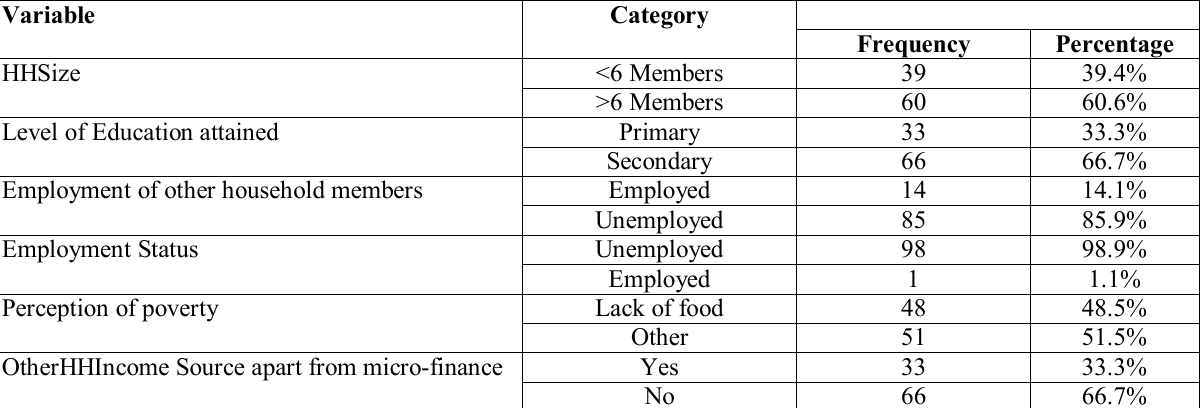
Table 1: Additional socio-demographic characteristics of the respondents' households